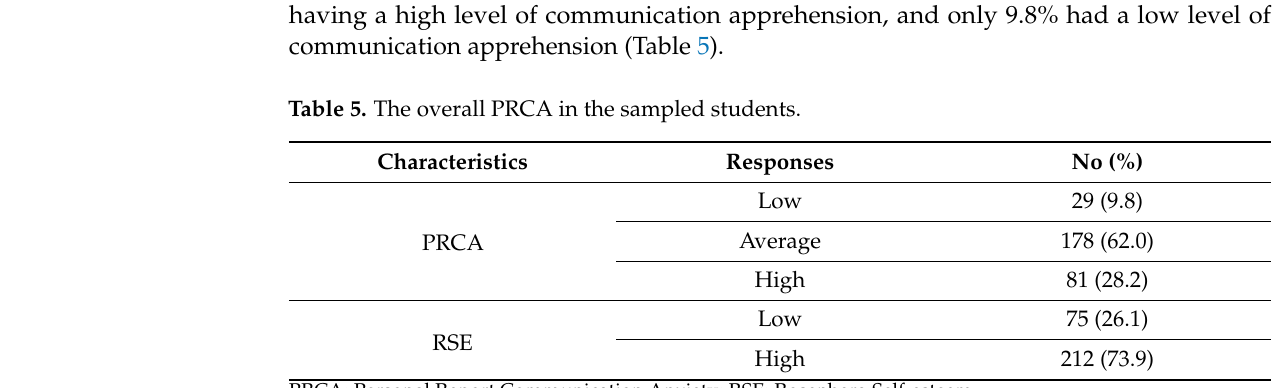
Table 5. the overall PRCA in the sampled students.